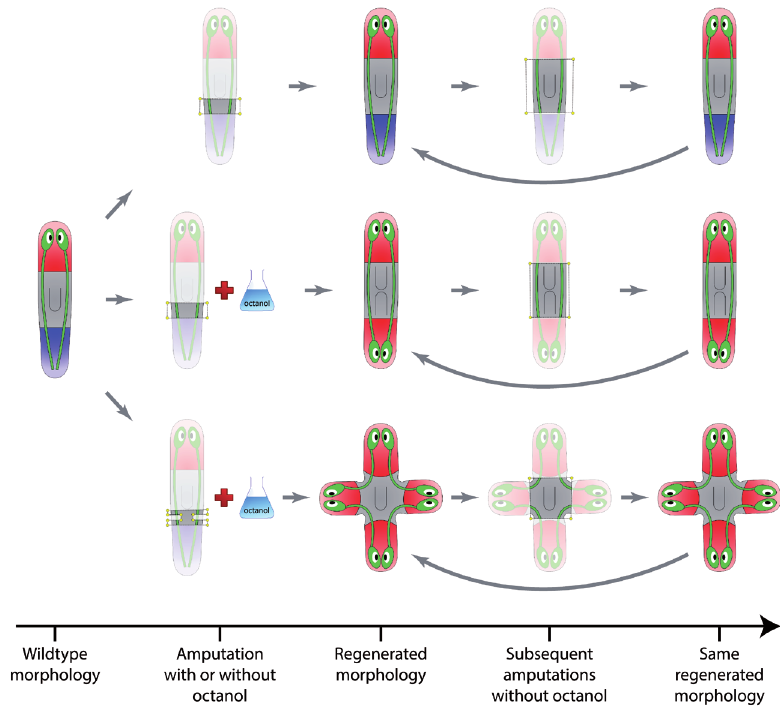
Figure 3. The plasticity of the target morphology in planarian worms. The regenerating phenotype from an amputated planarian trunk piece can be locally and permanently altered by non-genetic perturbations, suggesting a linear encoding of the target morphology outside the genome. Experiments extracted from Planform (Lobo et al. ,